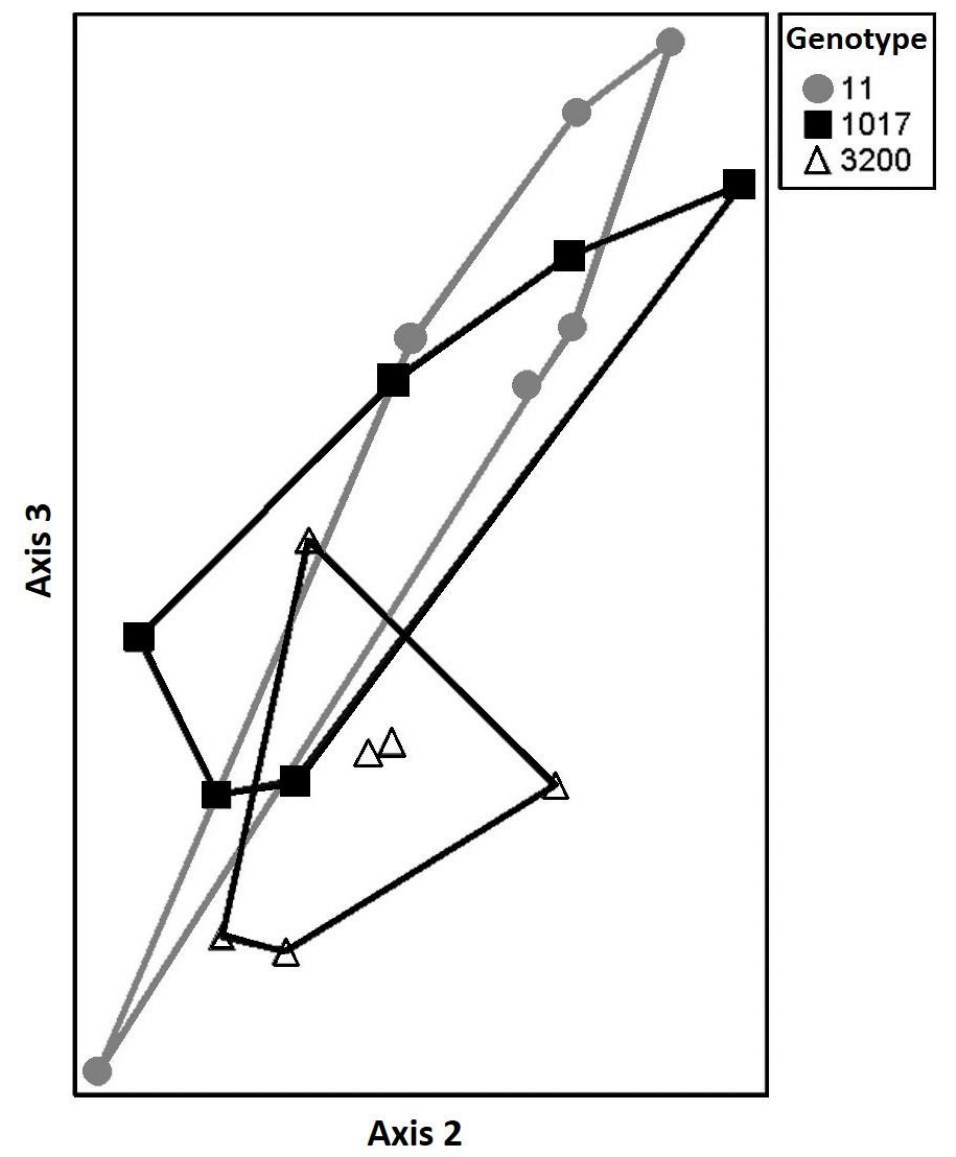
Figure 3. Non-metric multidimensional scaling (NMDS) ordination showing two distinct macroinvertebrate communities among three backcross hybrid cottonwood genotypes on harvest date 107 (Overall MRPP: A = 0.0937, p = 0.0458; 11 (cid:44) 3200: A = 0.1751, p = 0.0097). Symbols represent entire macroinvertebrate communities on a given litterbag. Distance between symbols is a graphical representation of community similarity with points closer in space more similar than points further apart for genotype 11 ( • ), genotype 1017 ( (cid:4) ) and genotype 3200 ( ∆